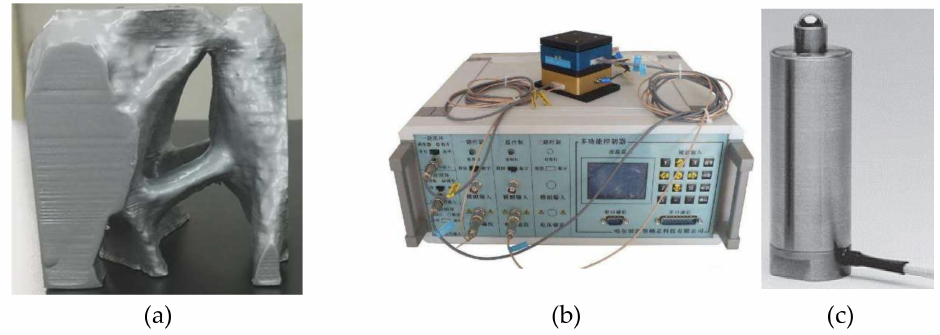
Figure 9. Topological structure, controller and actuator. ( a ) The physical model of the topological structure, ( b ) Controller, ( c ) PZT